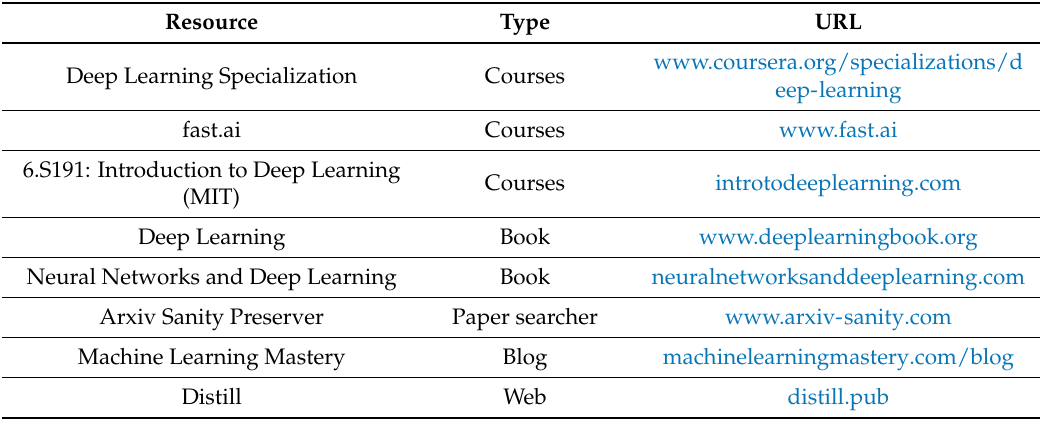
Table 1. Some DL resources for fundamental descriptions, research, and